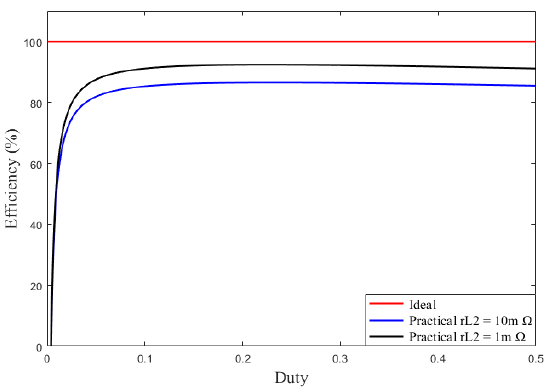
Figure 21. The calculated efficiency of the proposed topology considering conduction loss.